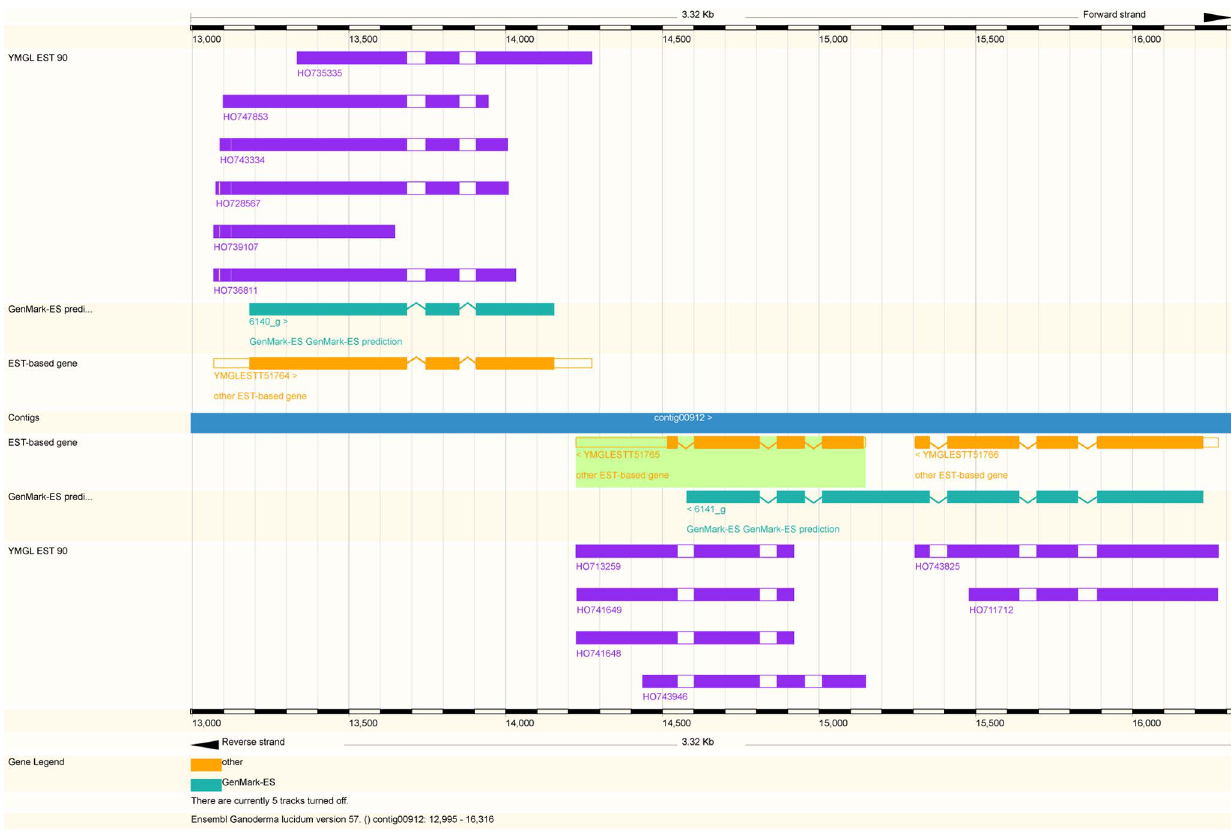
Figure 1. A tail-to-tail arrangement of sense and cis -NAT gene pairs, CCHL (YMGL ESTG/ESTT 51764) and TIM44 (YMGL ESTG/ESTT 51765). This figure presents an Ensembl-based visualization of the ESTs and ESTGenes/ESTTranscripts, YMGL ESTG/ESTT 51764 and YMGL ESTG/ESTT 51765, on top of G. lucidum genomic contig, contig00912. The former is annotated as cytochrome c heme lyase ( CCHL ) and the latter is annotated as mitochondrial import inner membrane translocase, subunit Tim44 ( TIM44 ). The EST transcripts were built from overlapping ESTs-genome using a ‘‘cluster and merge’’ algorithm (see the Materials and Methods for details) and only the ESTs sharing identical splicing junctions were merged into an ESTTranscript. The orientation of each transcript was inferred by fitting splicing junctions to the consensus GT-AG pattern. YMGL ESTG/ESTT 51764 and YMGL ESTG/ESTT 51765 are on opposite strands and their 3 9 regions corresponding to putative untranslated regions that overlap with each other (as indicated by the non-shaded area in each transcript). These two transcripts show a tail-to-tail arrangement between the sense and cis - natural antisense transcripts.